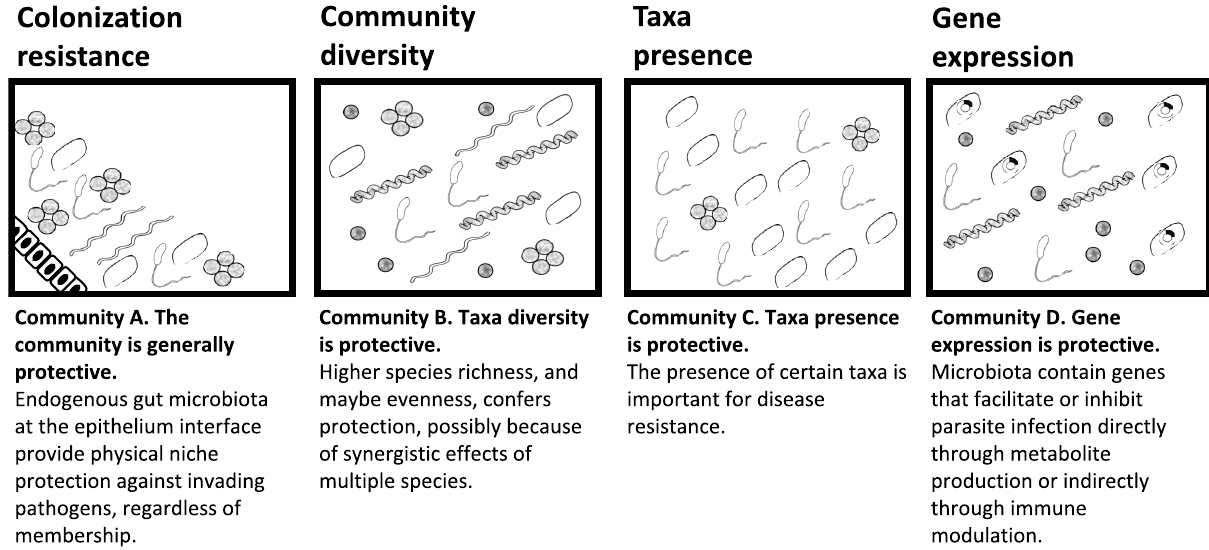
Fig 3. Properties of the gut microbiome that could reduce parasitism. The protective effects of the gut microbiome may derive from colonization resistance, the abundance and evenness of one or more species at various taxonomic levels, the presence or absence of particular species, or the presence or abundance of certain genes. These scenarios are not exhaustive nor mutually exclusive